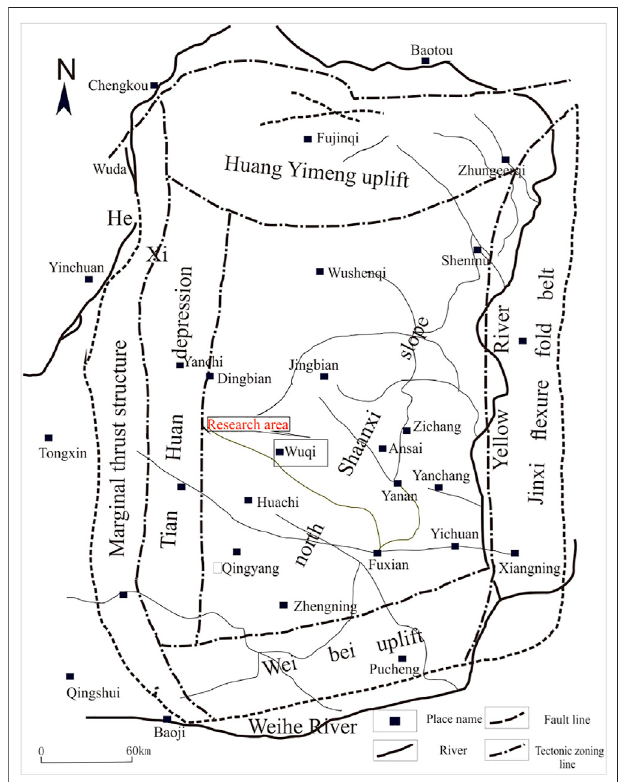
FIGURE 1 | Regional overview of the study